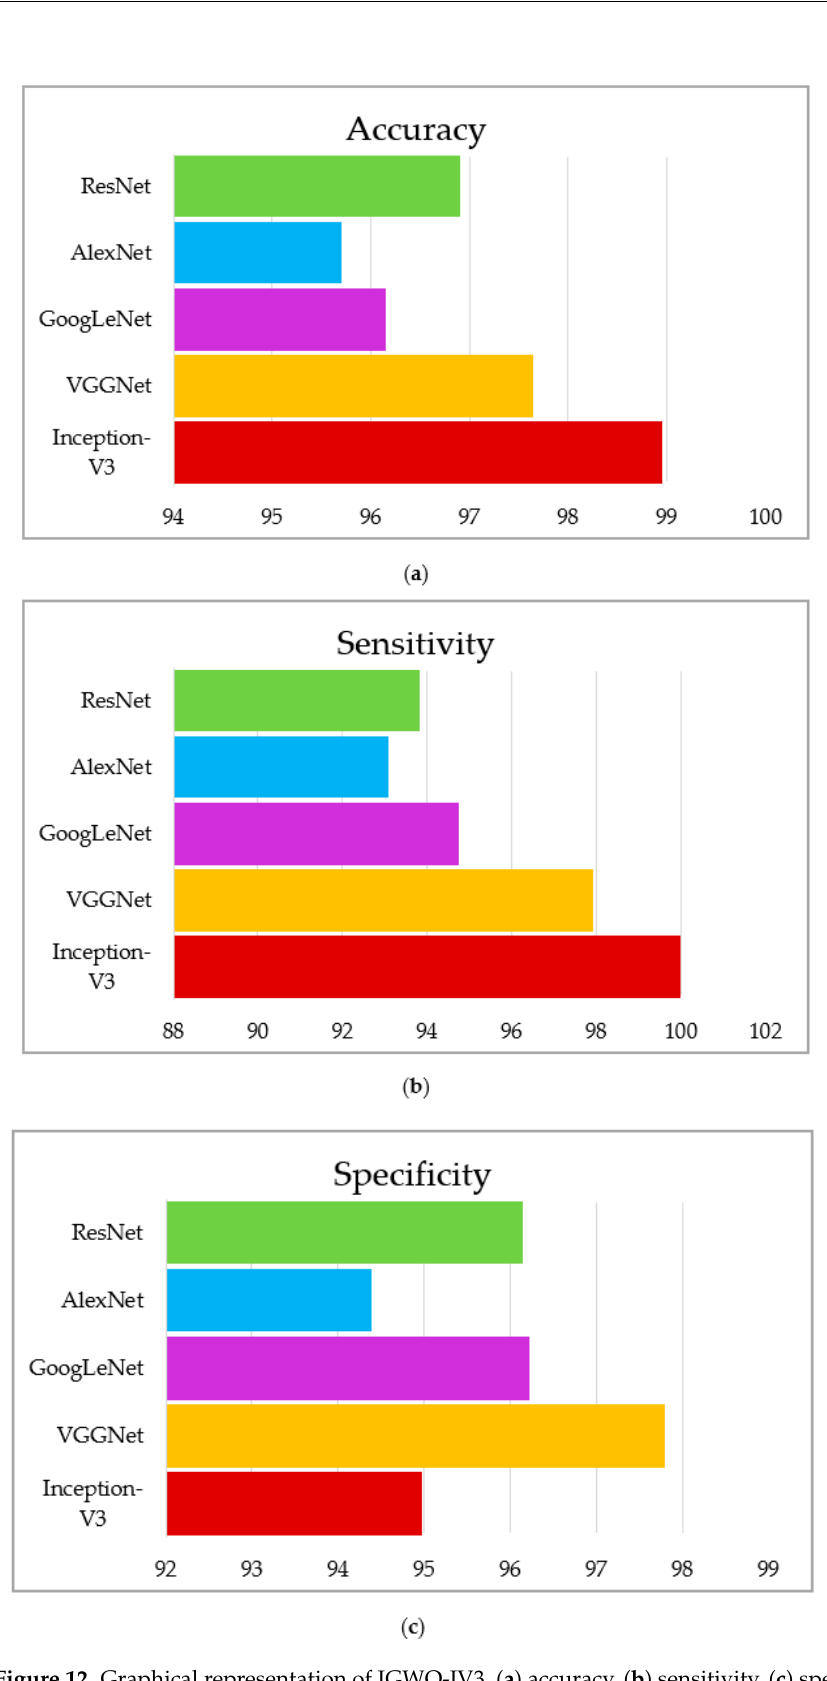
Figure 12. Graphical representation of IGWO-IV3, ( a ) accuracy, ( b ) sensitivity, ( c ) specificity.